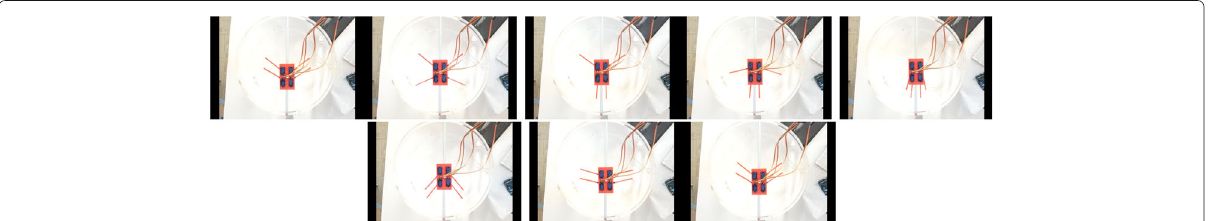
Fig. 28 A sequence of configurations for the copepod during a stroke. The power strokes can be seen in the first 5 snapshots and the return part of the stroke with both legs moving together is displayed in the last three snapshots